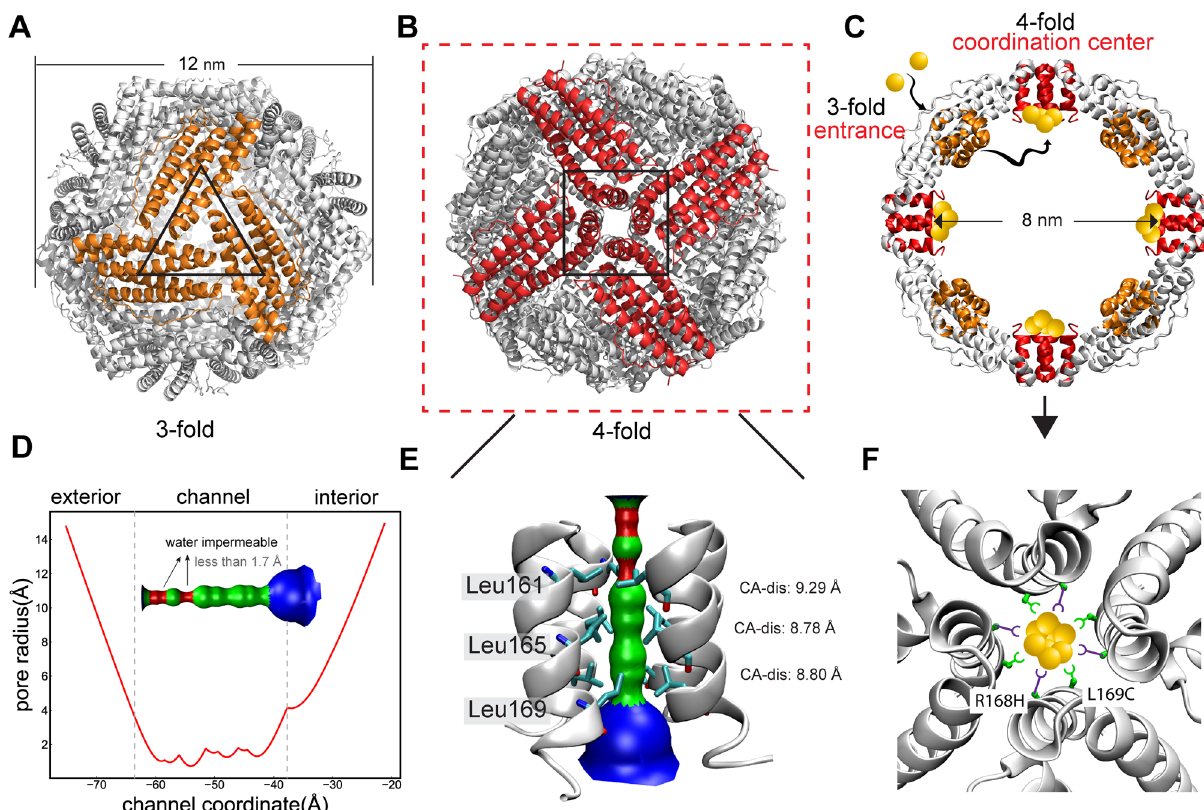
Fig. 1 Structure of the ferritin and schematic presentation of the designed strategy. Overall cage structure showing ( A ) 3-fold and ( B ) 4-fold symmetric facing front, respectively. C Interior cage structure of the ferritin cage showing the locations of the 4-fold channel (red helices) and schematic representation of the designed Au(I) accumulation pathways. D Pore radius along the 4-fold axis channel from the exterior to the interior of the rHLFr cage. E Hole con fi guration of the 4-fold axis channel with key residues contacting the channel interior. F Schematic presentation of the designed strategy for gold cluster formation at the 4-fold axis channel of the mutant apo-R168H/L169C-rHLFr. (Figures are prepared in PyMol and